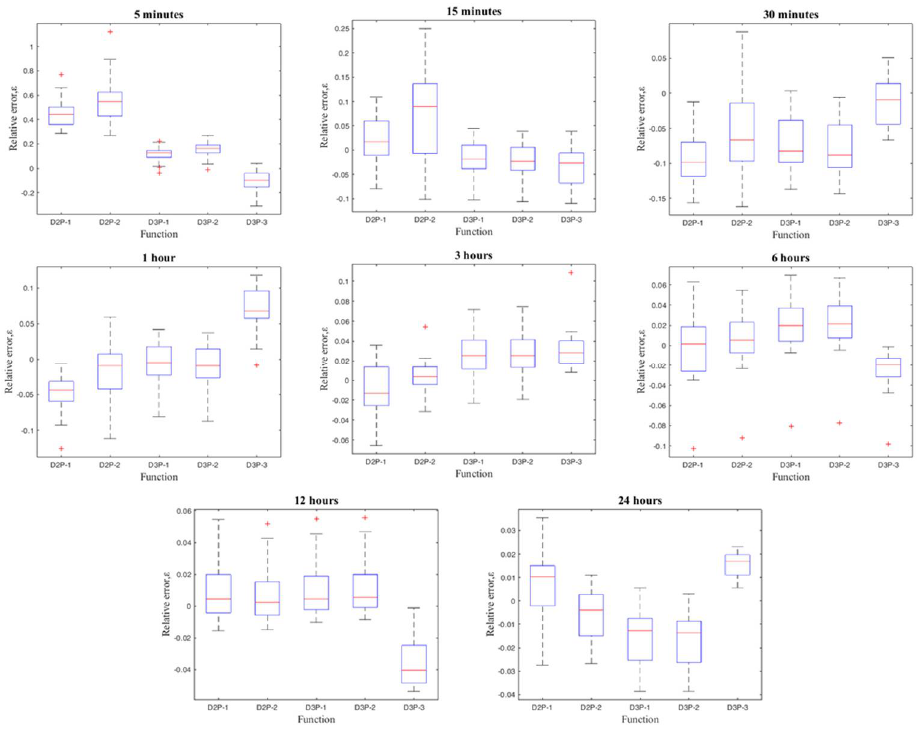
Figure 4. Boxplots of the relative errors evaluated for sub hourly and hourly rainfall durations, with reference to all considered DDFs.